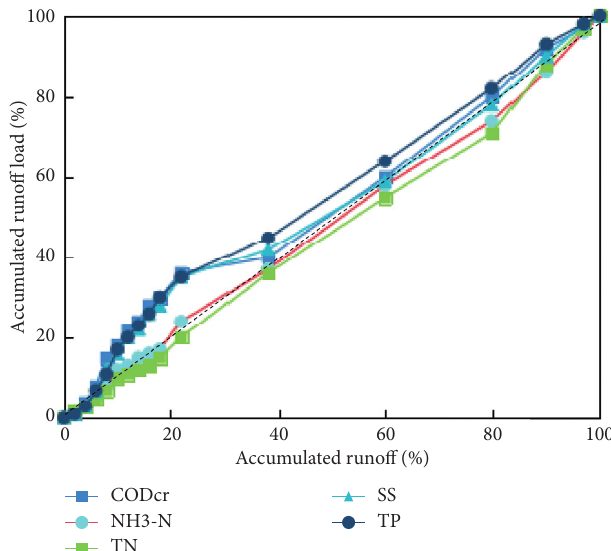
Figure 4: Prediction results of real-time pollution simulation through the proposed method.